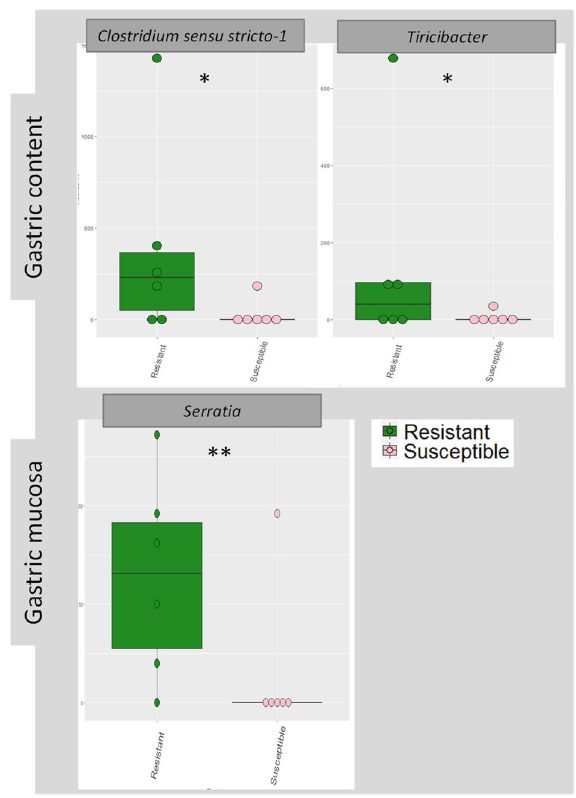
Figure 2. Boxplot showing significant or slight significant differences for RG and SG in gastric content ( Clostridium sensu stricto 1; p = 0.08 and Turicibacter ; p = 0.07), and gastric mucosa ( Serrata spp ; p = 0.05). Significant differences are indicated by ** (p < 0.05) and slight significant differences by * ( p between 0.05–0.01).